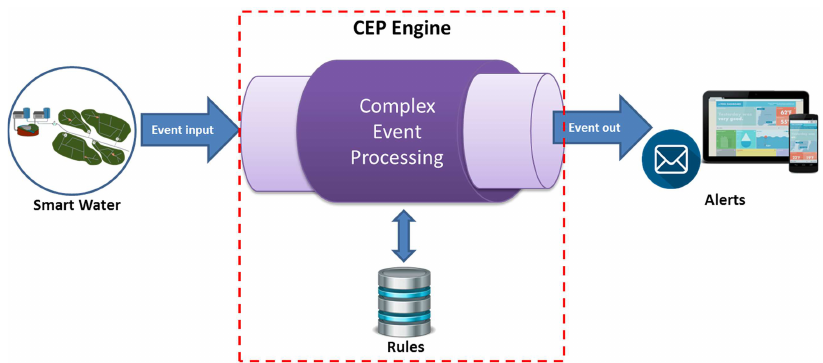
Figure 6. Complex Event Processing (CEP) architecture.